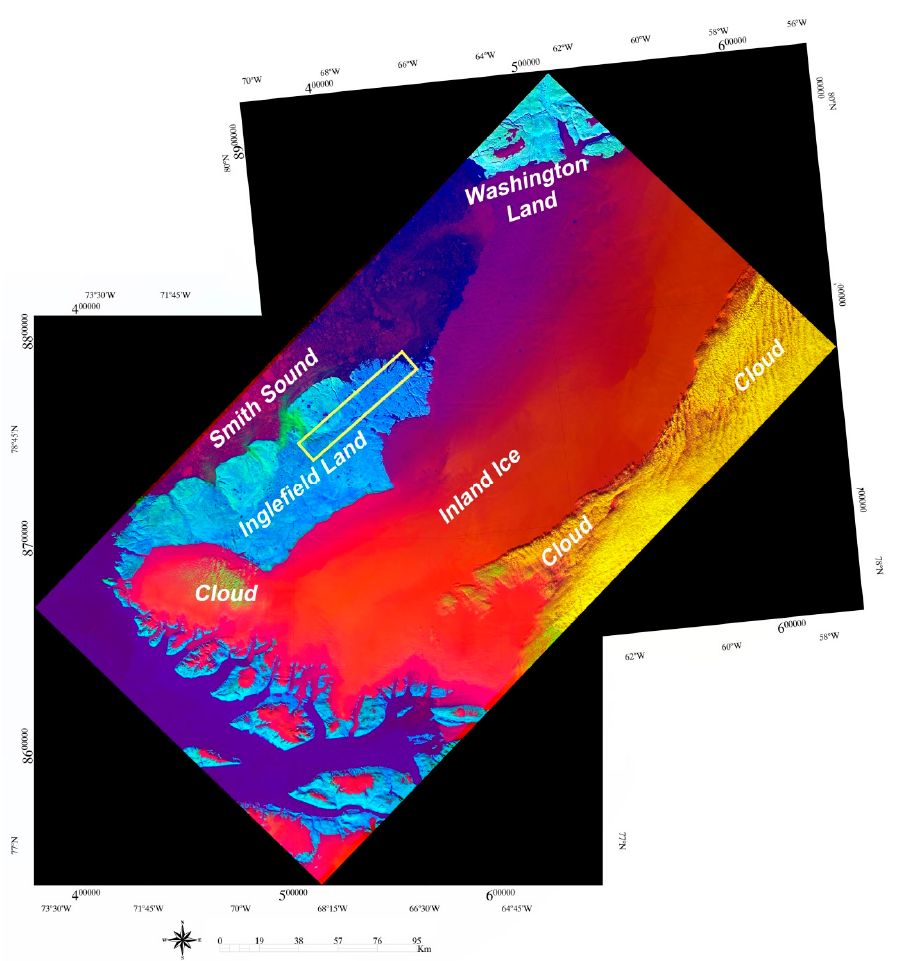
Figure 4. A regional view of the northwestern part of Greenland generated using a mosaic of Landsat-8 images as RGB false-color composite of the normalized di ff erence snow index (NDSI), Al-OH-bearing alteration minerals index (Al-OH-MI), and thermal radiance lithology index (TRLI). Yellow rectangle shows the location of the Cu-Au mineralization belt.